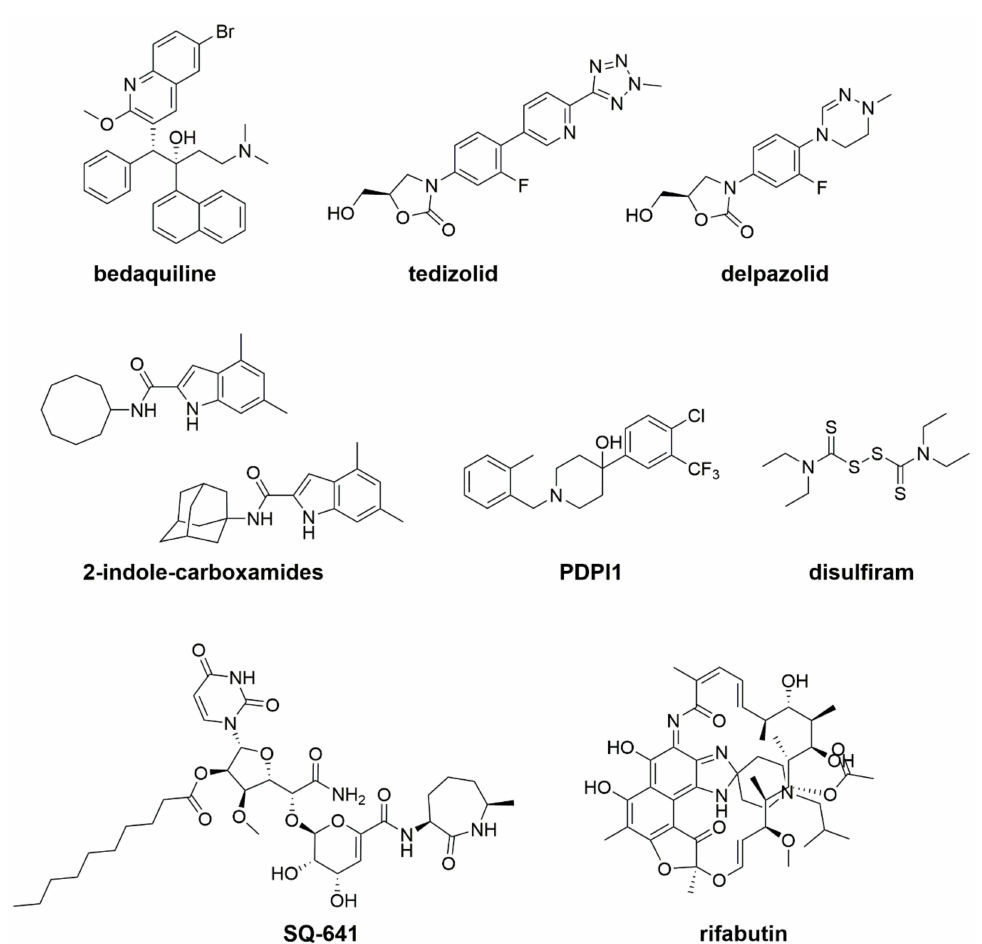
Figure 3. Anti- Mab drugs in preclinical and clinical